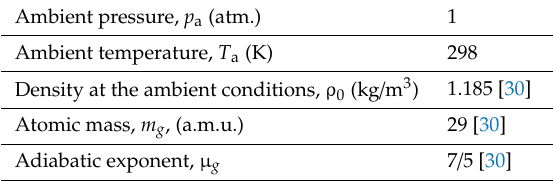
Table 2. Properties of air accepted for